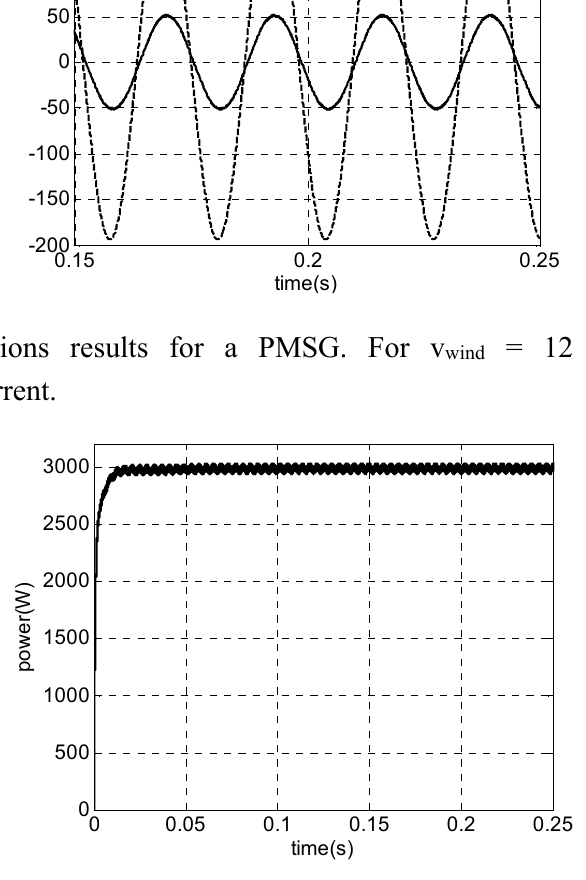
Figure 17. Simulations results for a PMSG. For v wind = 12 m/s (rated power): electrical